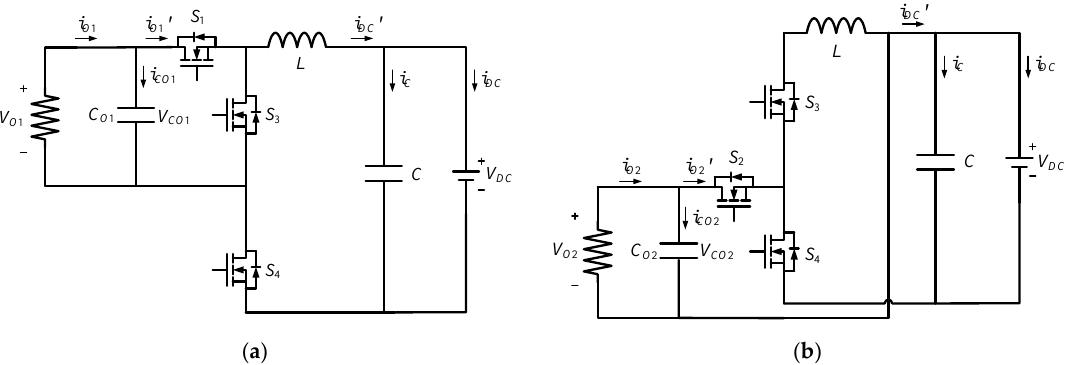
Figure 6. Equivalent circuit diagrams of ( a ) The charging scenario A; ( b ) The scenario mode B.